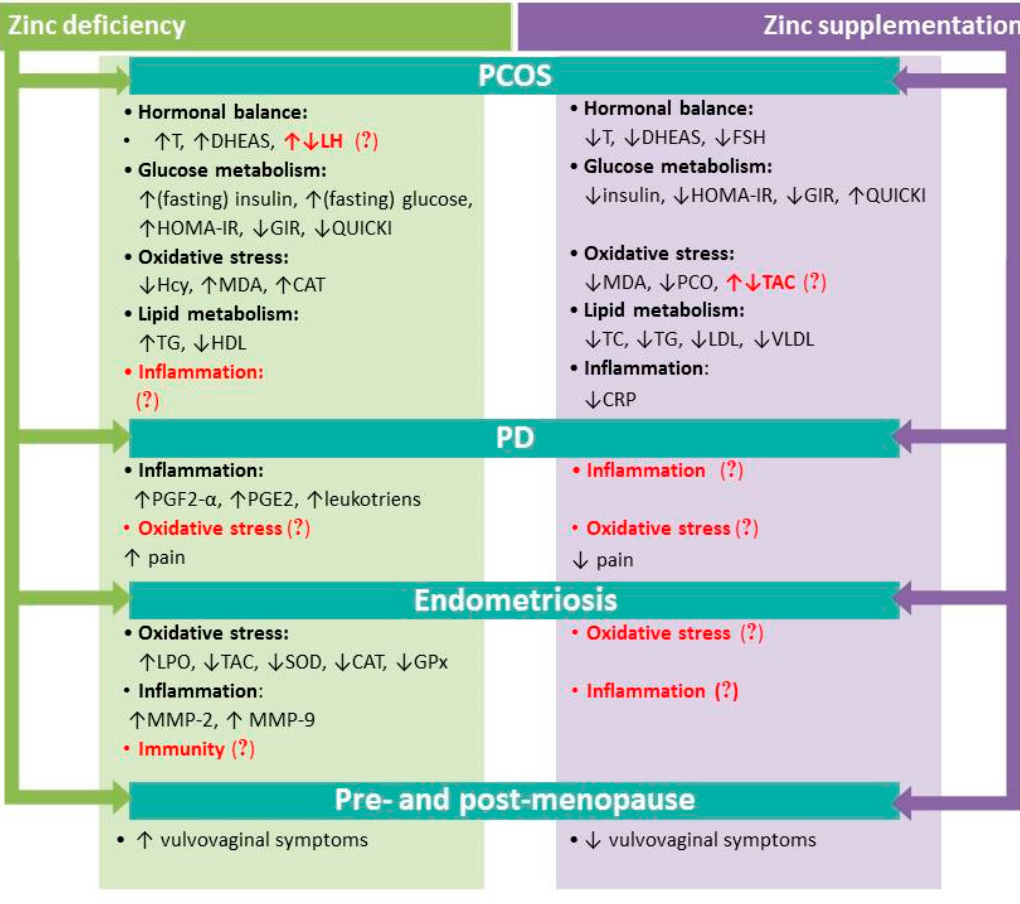
Figure2. Summaryofthee ff ectsofzincdeficiencyandzincsupplementationinPCOS,PD,endometriosis Figure 2. Summary of the effects of zinc deficiency and zinc supplementation in PCOS, PD, and menopause. Question marks indicate uncertainty / gaps requiring elucidation and further endometriosis and menopause. Question marks indicate uncertainty/gaps requiring elucidation and further research.